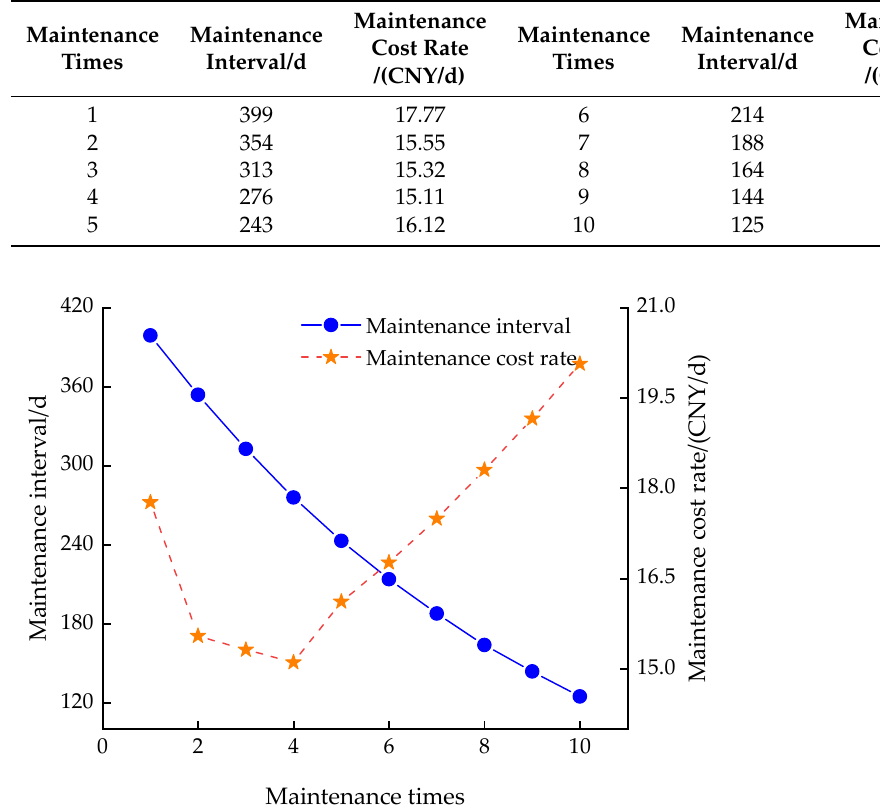
Figure 7. Curve of preventive maintenance interval time and maintenance cost rate for the power supply module.